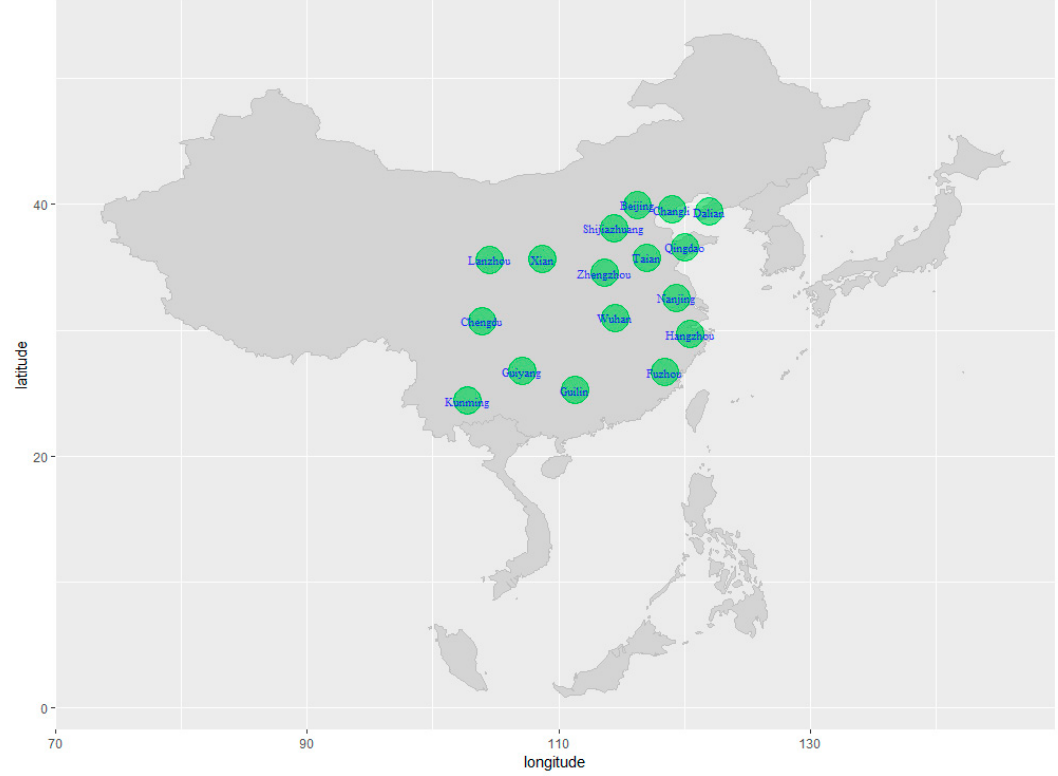
Figure 1. The position diagram of the 17 stations where G. molesta data were sampled (2009–2021).